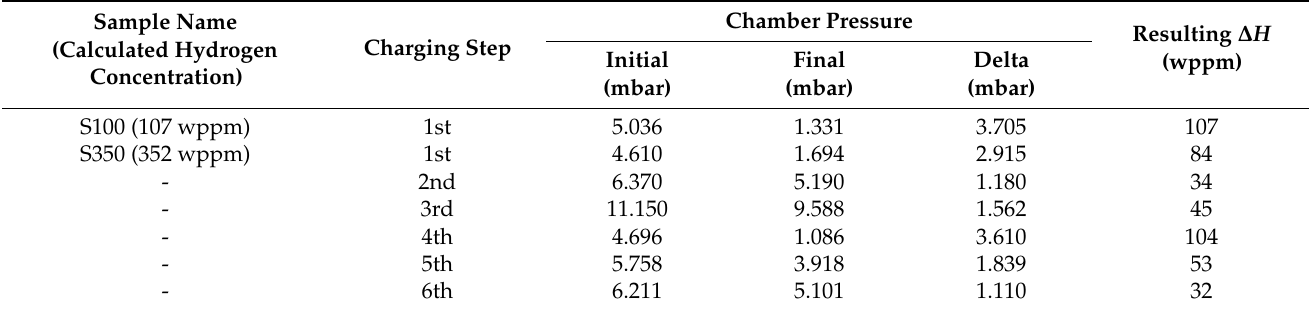
Table 1. Hydrogen pressures recorded during hydrogenation process. Sample S100 was obtained with a single dose. Sample S350 was obtained with three incremental small doses, followed by homogenization and quenching, followed by three subsequent hydrogenation doses.